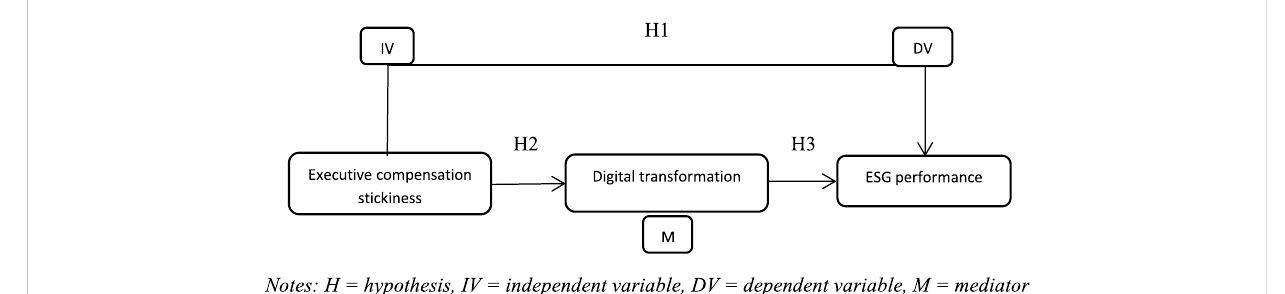
FIGURE 1 Research framework. Notes: H, hypothesis; IV, independent variable; DV, dependent variable; M, mediator.